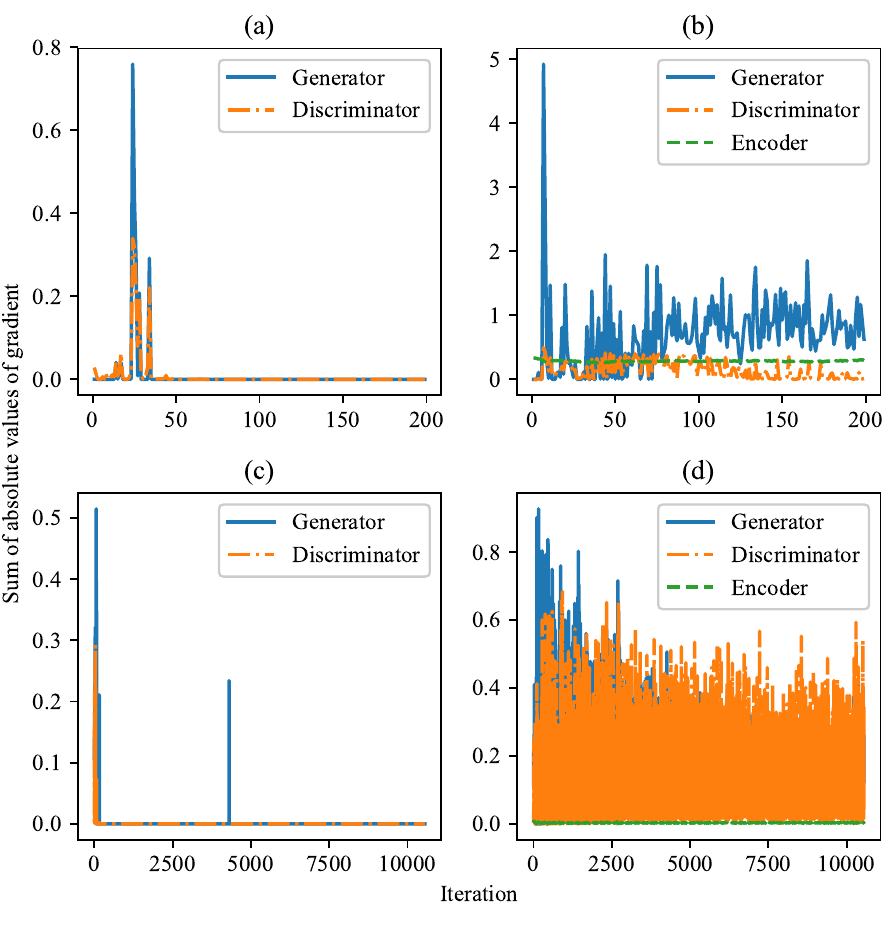
Figure 4. Plots of the variations of the sum of absolute values of gradient when the ‘vanishing gradient’ phenomenon artificially occurs. ( a ) GAN for the MNIST dataset; ( b ) VLGAN for the MNIST dataset; ( c ) GAN for the CelebA dataset; ( d ) VLGAN for the CelebA